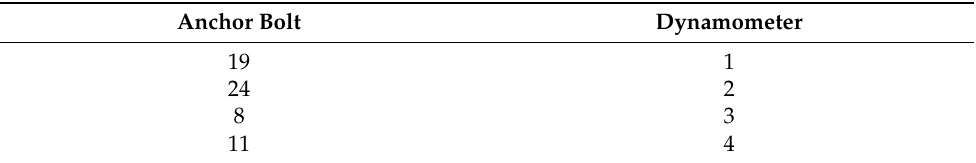
Table 2. Assignment of dynamometers to anchor bolts.